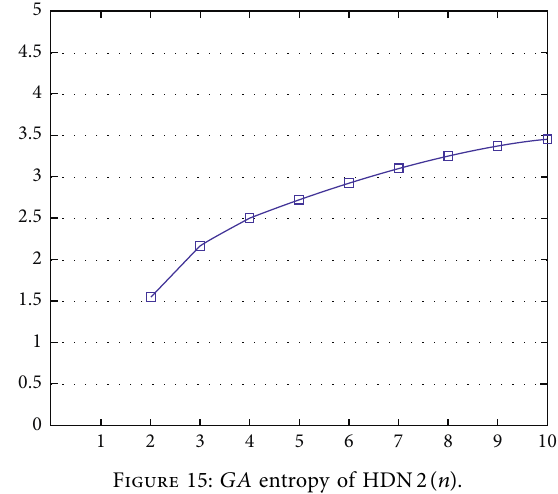
Figure 12: Randi´c entropy of HDN2 ( n ) for α � − 1.